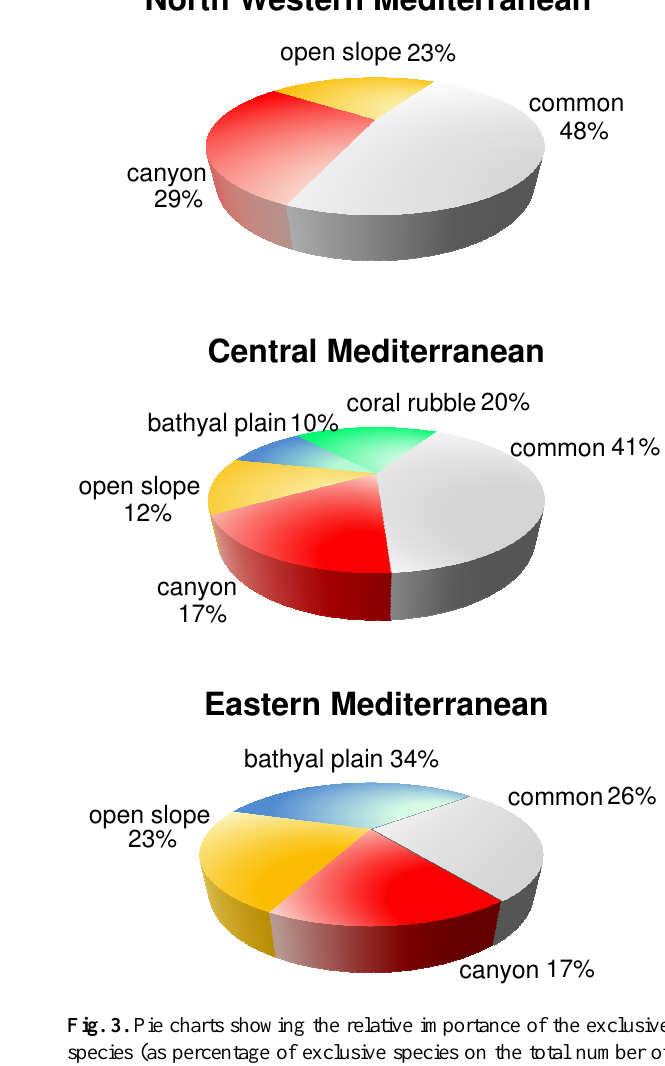
Fig. 3. Pie charts showing the relative importance of the exclusive species (as percentage of exclusive species on the total number of species retrieved in the region) in each of the habitats investigated, along with the species in common to all of these habitats in the north-western, central and eastern Mediterranean regions.